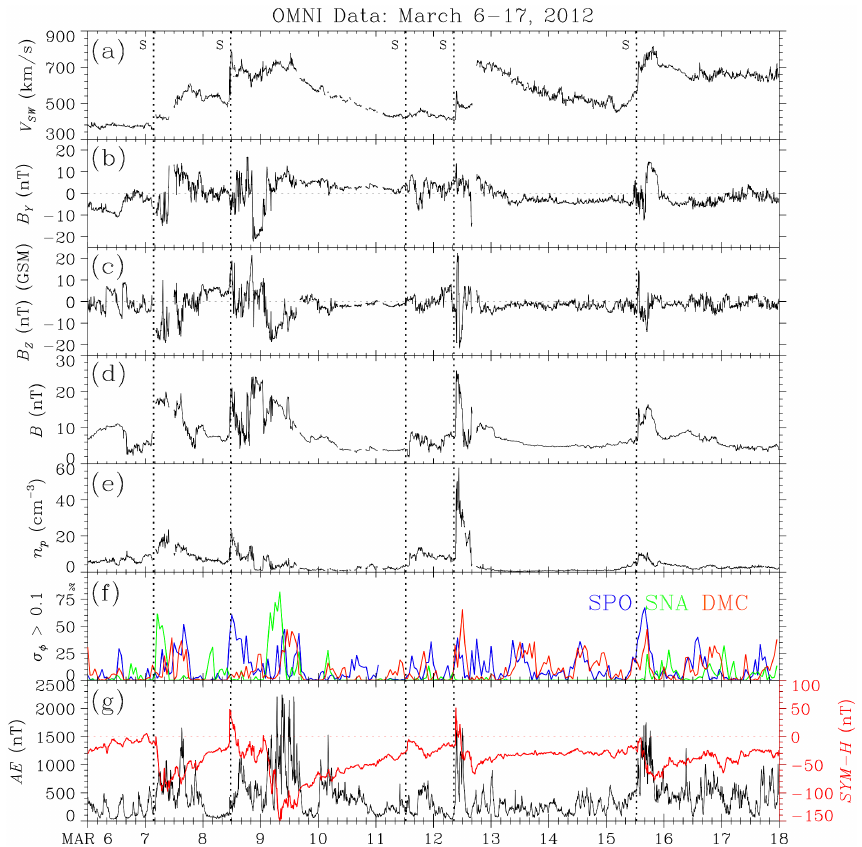
Figure 2. The interplanetary data from the 5min OMNI data set. The hourly occurrences of phase scintillation ( σ (cid:56) >0.1rad) observed at South Pole (SPO), Concordia (DMC) and SANAE (SNA), and provisional geomagnetic indices AE and SYM-H are shown in the bottom two